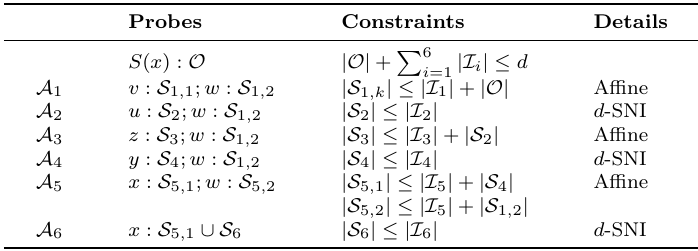
Table 3: Proof that the S-box in Figure 7 is d -SNI for d = 1 , 2 Probes Constraints